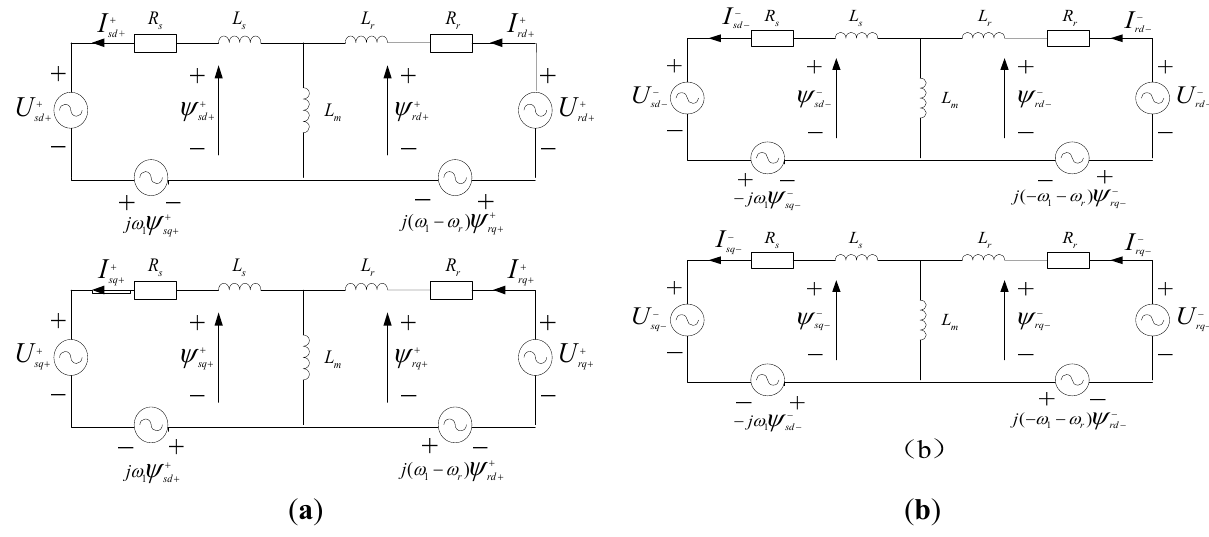
Figure 1. Equivalent circuit model of the doubly-fed induction generator